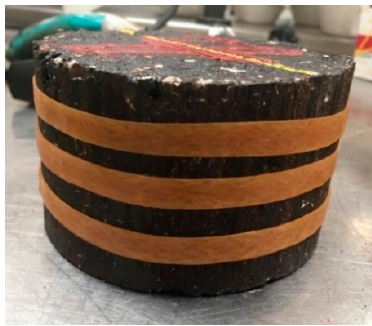
Figure 6. Simulation of in situ confining conditions of the asphalt pavements.